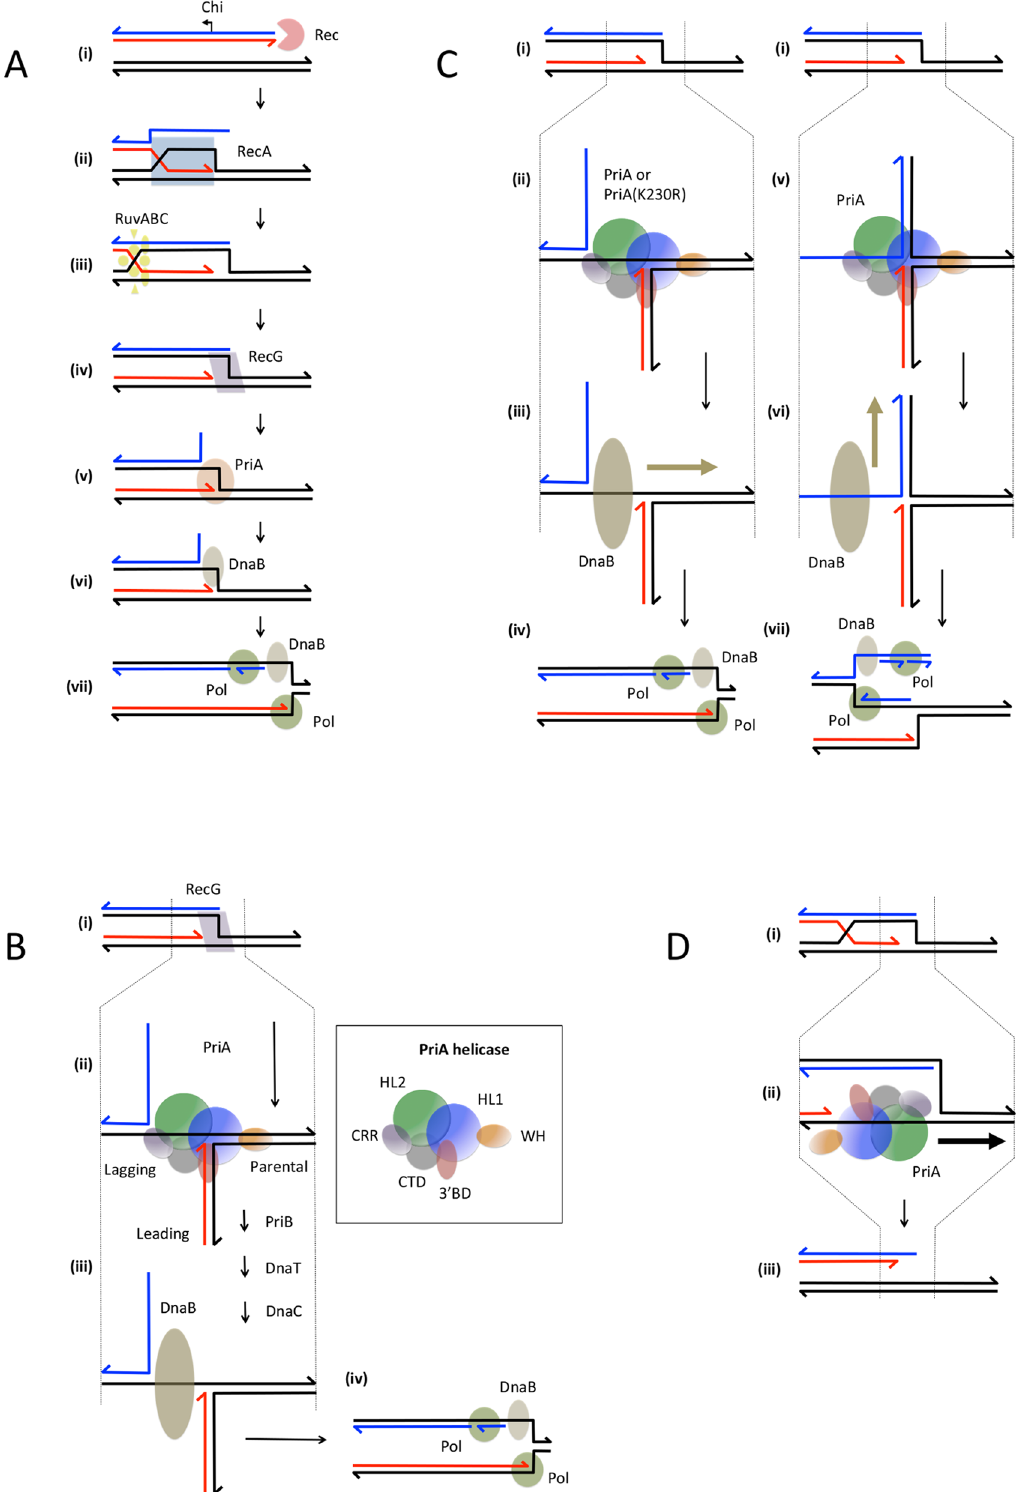
Fig 5. Model depicting the proposed action of RecG and PriA in the RecBCD recombination pathway. A. Revised model for the RecBCD recombination pathway. (i) The RecBCD enzyme recognises and binds to a DNA double-strand end. (ii) RecBCD generates a substrate with a 3 ’ end adjacent to a Chi site (shown as an arrow pointing in the direction of recombination stimulation) and a 5 ’ overhang. Continued unwinding by the